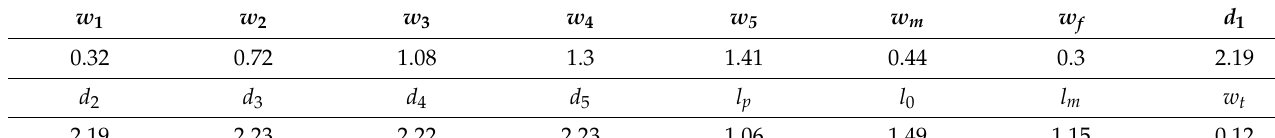
Figure 1. The geometry of the low SLL, linear series-fed patches sub-array.